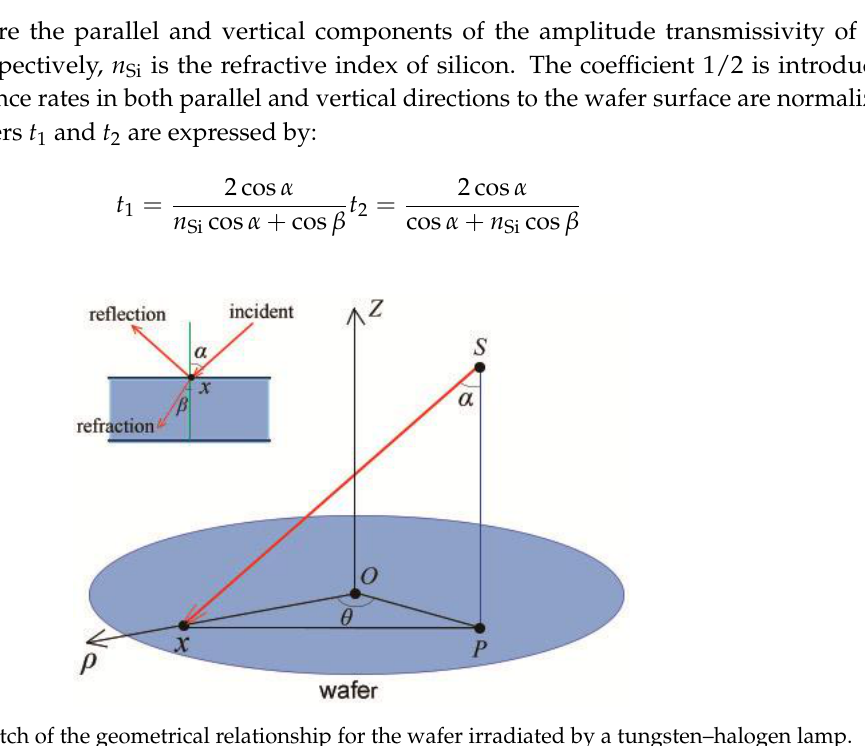
Figure 2. A sketch of the geometrical relationship for the wafer irradiated by a tungsten–halogen lamp. The inset shows the reflection and refraction of a ray incident on the silicon wafer.